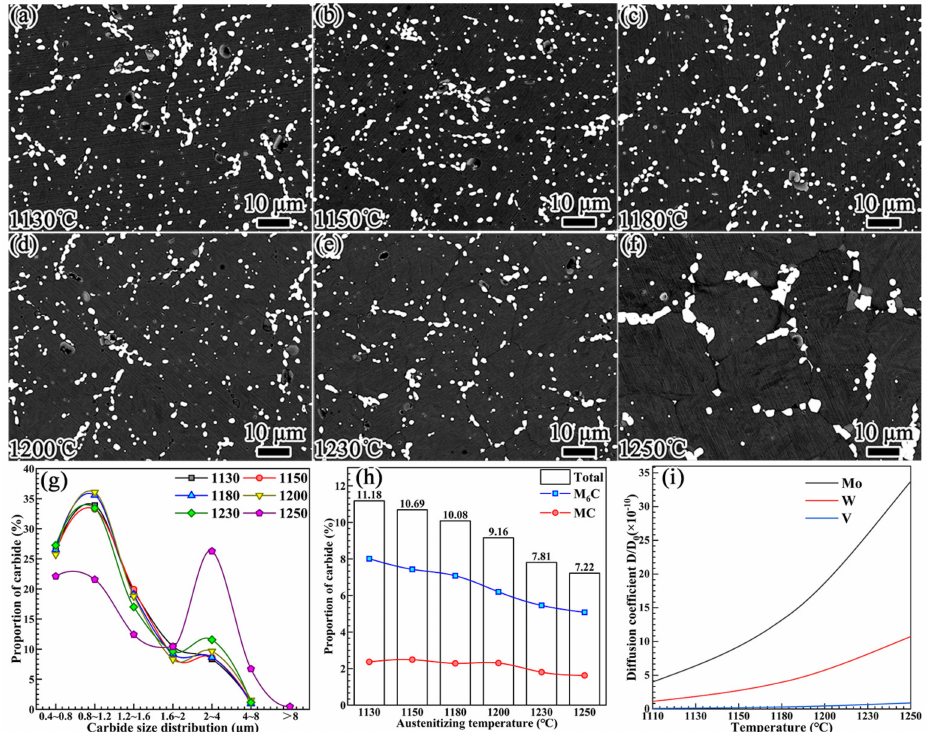
Figure 9. The evolution of carbides at different quenching temperatures: ( a ) 1130 ◦ C, ( b ) 1180 ◦ C, ( c ) 1230 ◦ C, ( d ) 1250 ◦ C, ( e ) 1230 ◦ C, and ( f ) 1250 ◦ C. ( g ) The percentages for the carbide particle size distribution. ( h ) Percentages for the carbide proportions. ( i ) Diffusion coefficients of Mo, W, and V elements as functions of